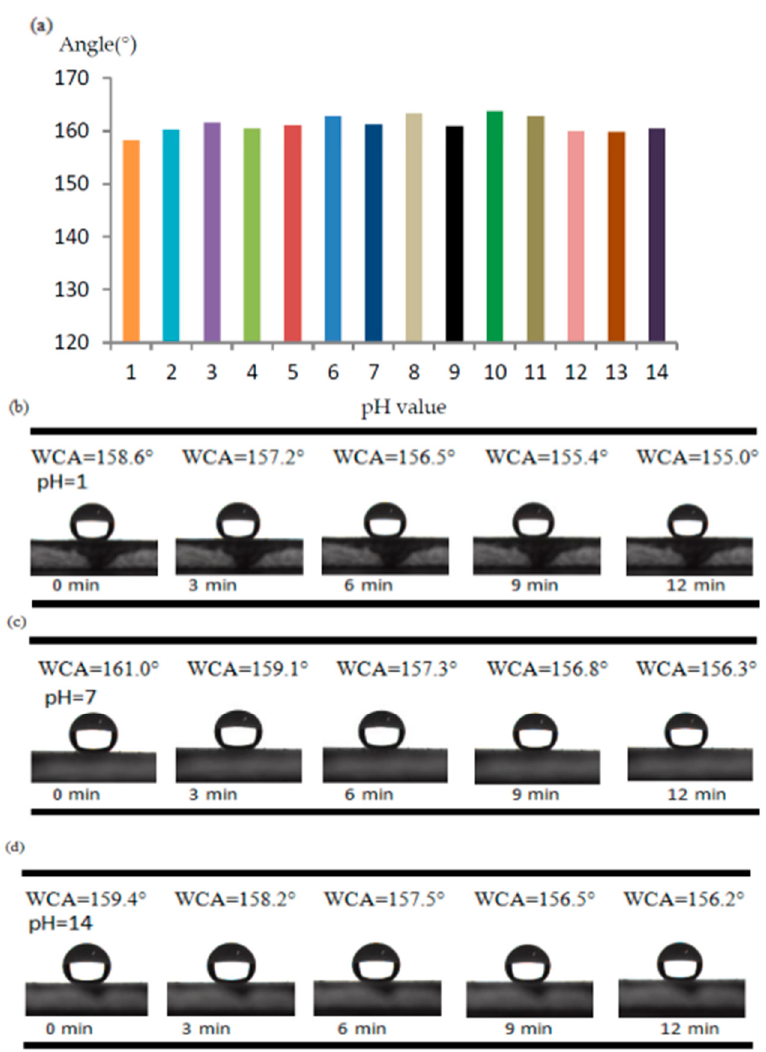
Figure 8. ( a ) WCAs of water droplets with different pH on the D coating; change in status of water droplets with ( b ) pH = 1; ( c ) pH = 7; and ( d ) pH = 14 over time on the D coating.